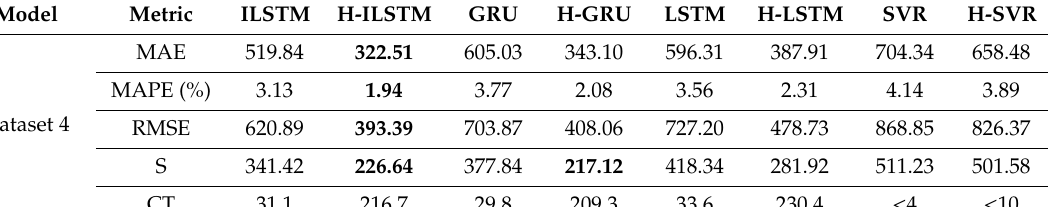
best predictions among the eight models).